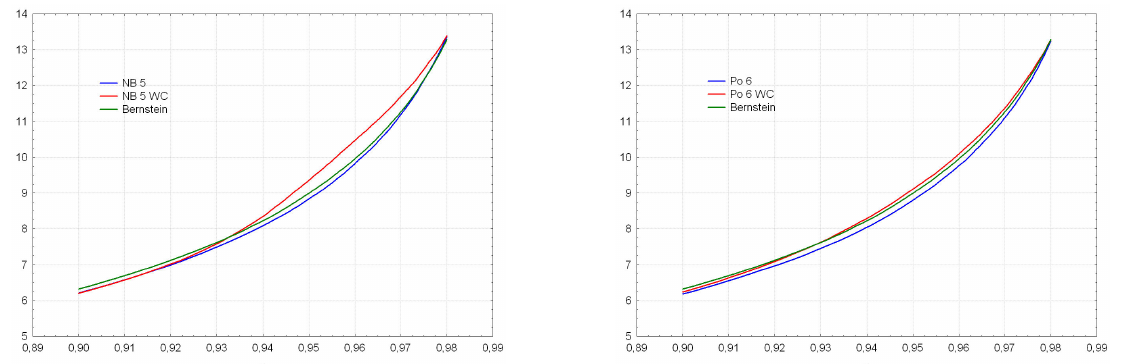
Figure 23: Empirical quantile